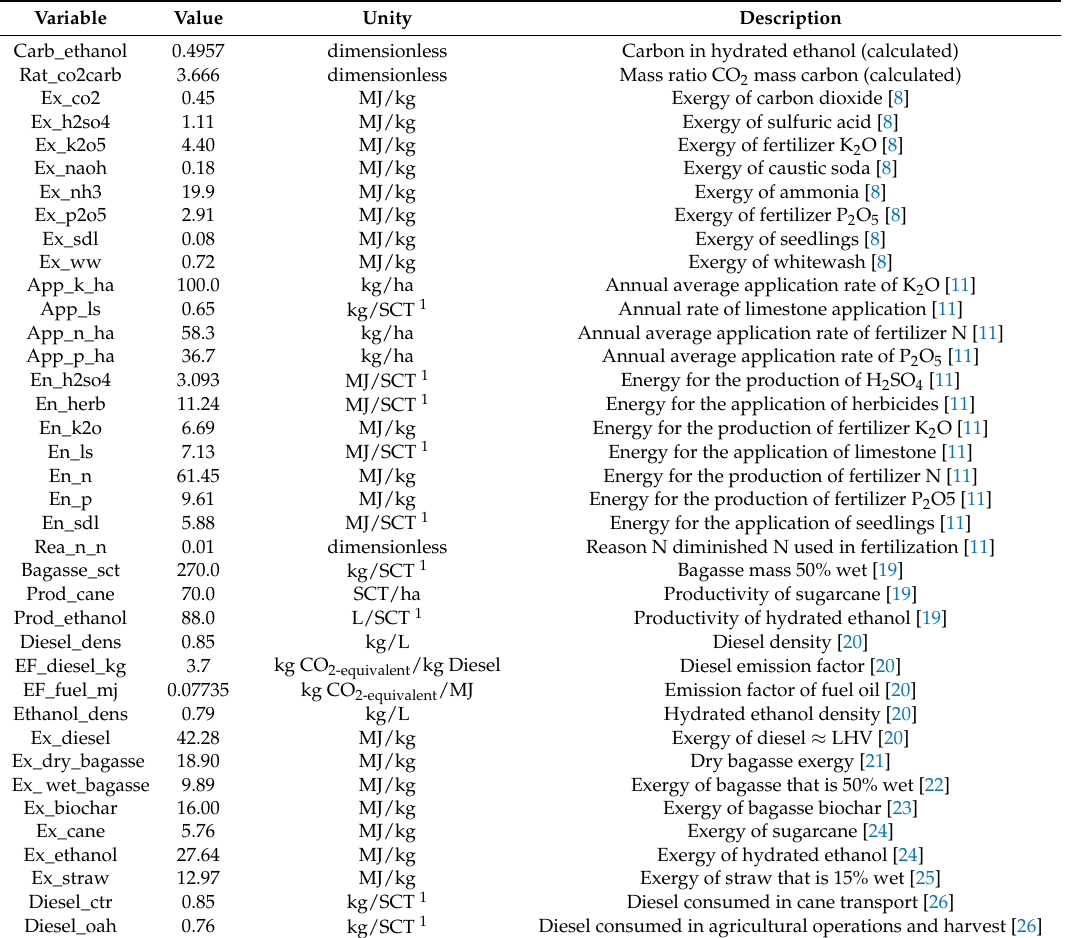
Table 1. Reference values used in the calculation of inventory.